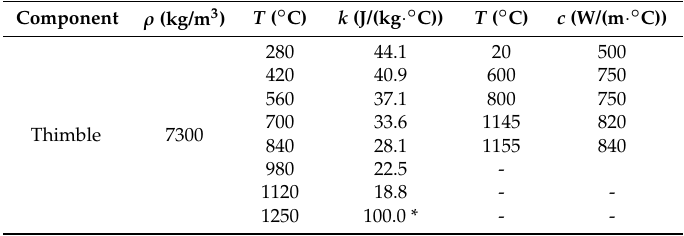
Table 4. Thermophysical